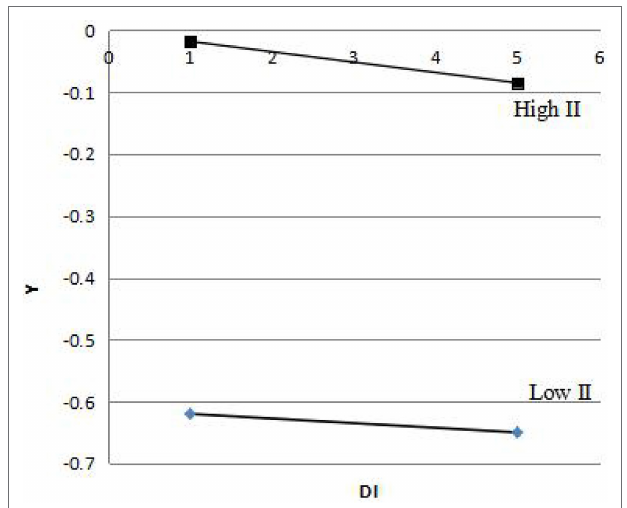
FIGURE 1 | The interaction effect of employee indirect involvement on employee direct involvement. DI, direct involvement; II, direct involvement.